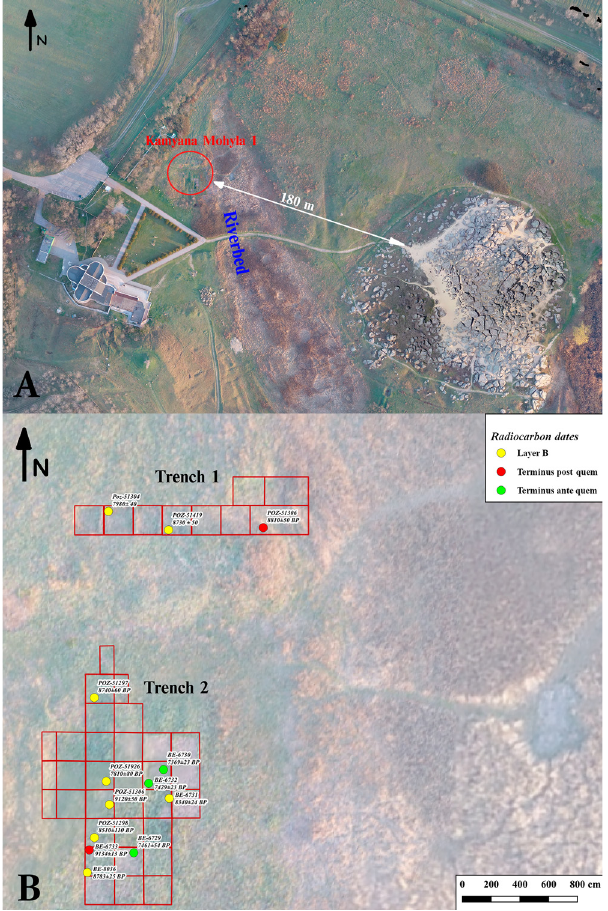
Figure 3: ( a ) Situational plan of the Kamyana Mohyla 1 site ( red circle ) ; ( b ) Location of excavation trenches on the site of Kamyana Mohyla 1 with indication of sampling for radiocarbon